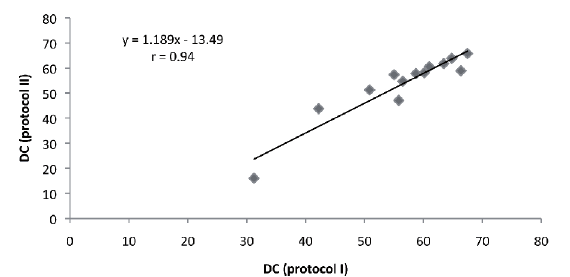
Figure 1 - Correlation between the DC determined when using the two protocols to obtain the uncured material spec-